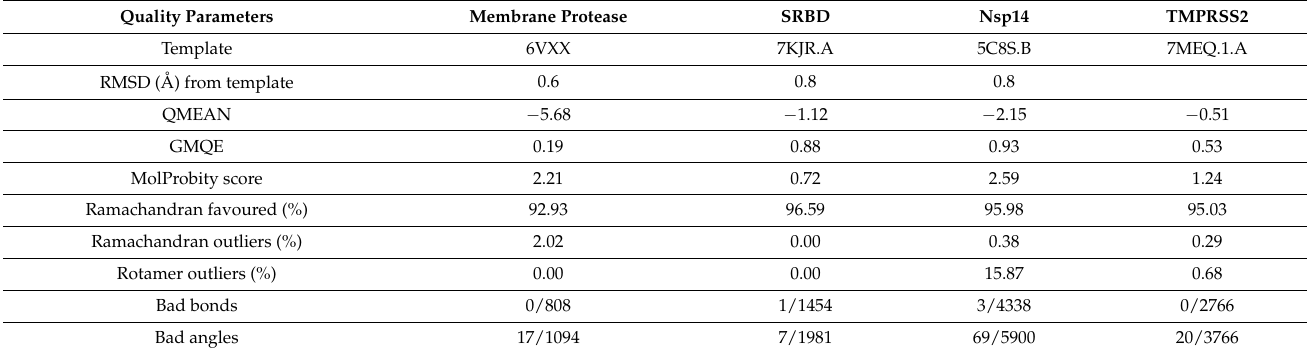
Table A1. Evaluation of the structural quality of the modeled structures.